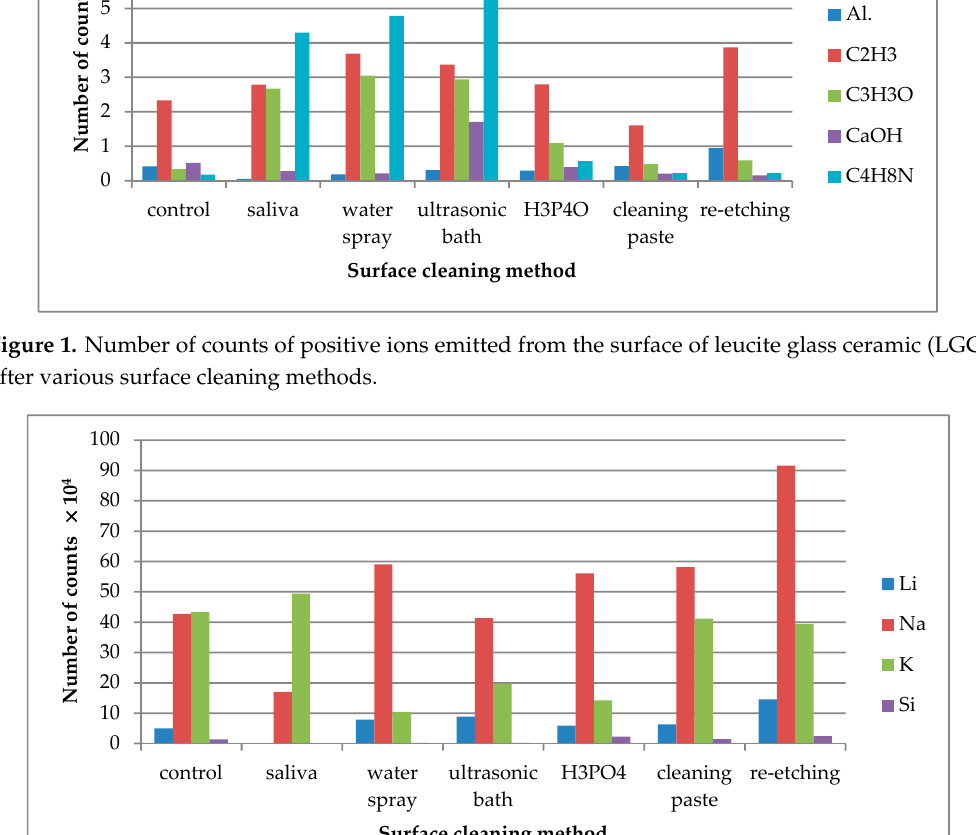
after various surface cleaning methods.